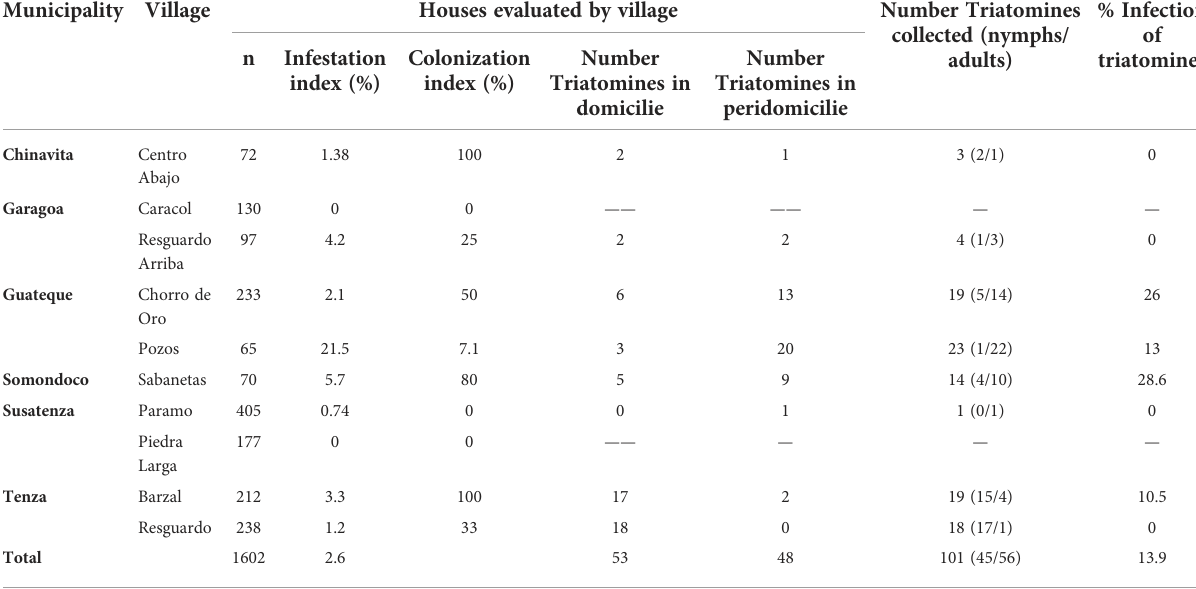
TABLE 1 Summary of entomological information and T. cruzi infection in T. venosa specimens. Municipality Village Houses evaluated by village Number Triatomines